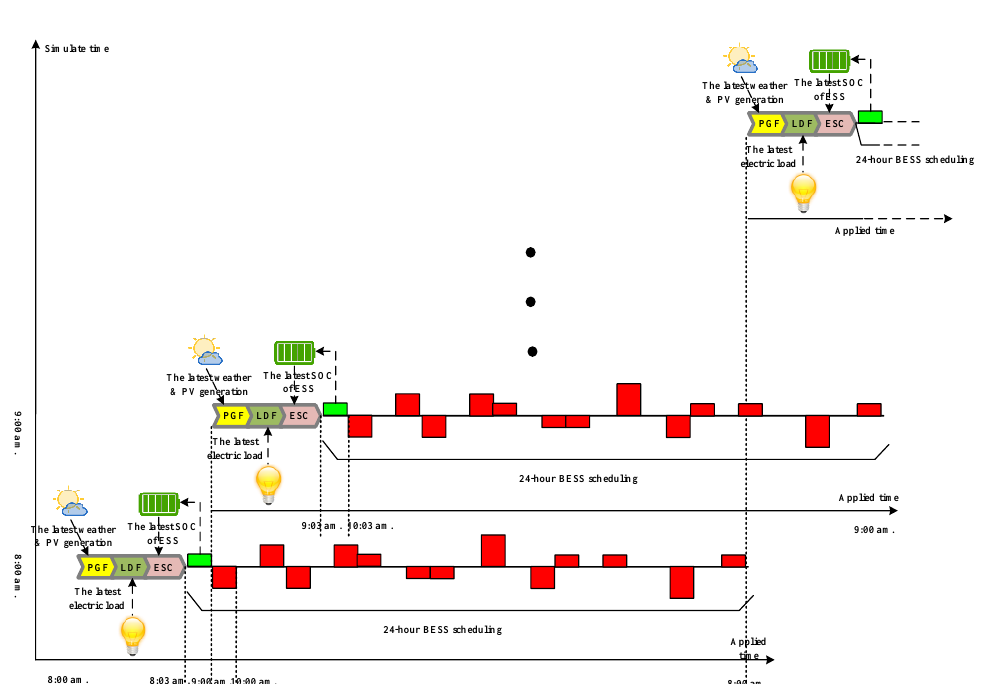
Figure 1. Schematics of the rolling-horizon-based battery energy storage system (BESS) scheduling.